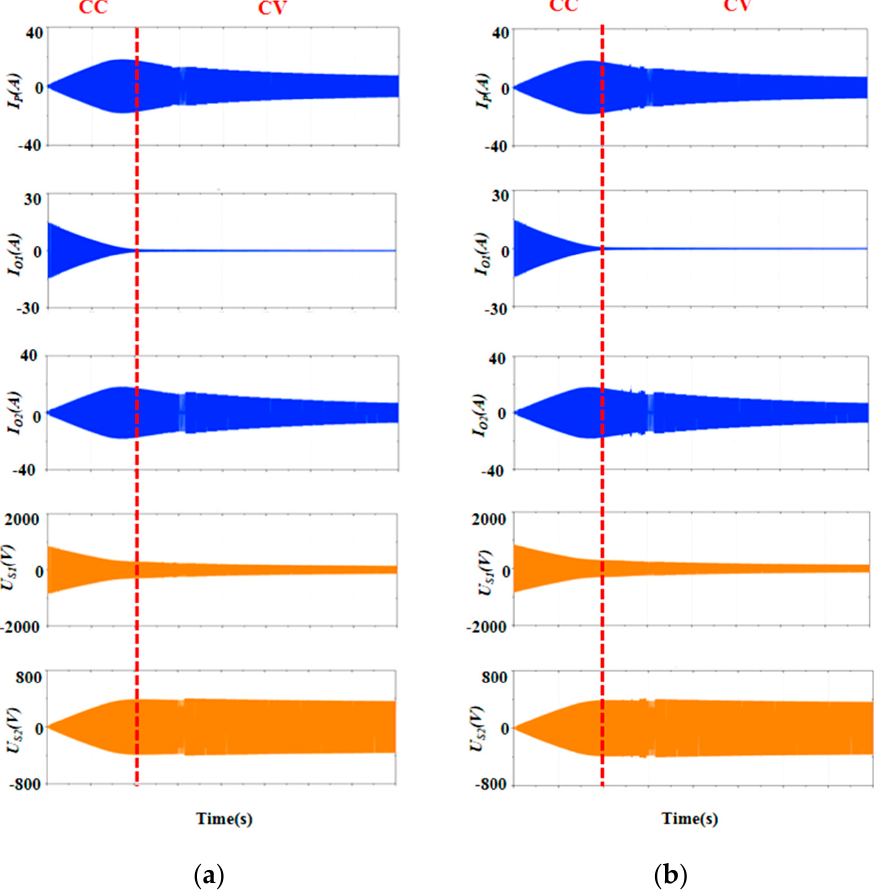
Figure 25. Converter waveform on primary and secondary side ( a ) simulated; ( b ) experimental.